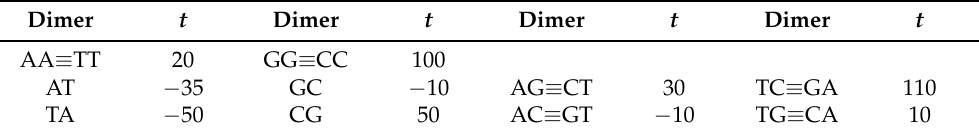
Table 1. Interaction integrals for hole transfer between consecutive base pairs; values taken from Ref. [18]. All values are given in meV. The notation XY means that dimers are named using their bases in the 5 (cid:48) –3 (cid:48) direction. Hence, e.g., TG ≡ CA, since the sequence TG in the 5 (cid:48) –3 (cid:48) direction of one